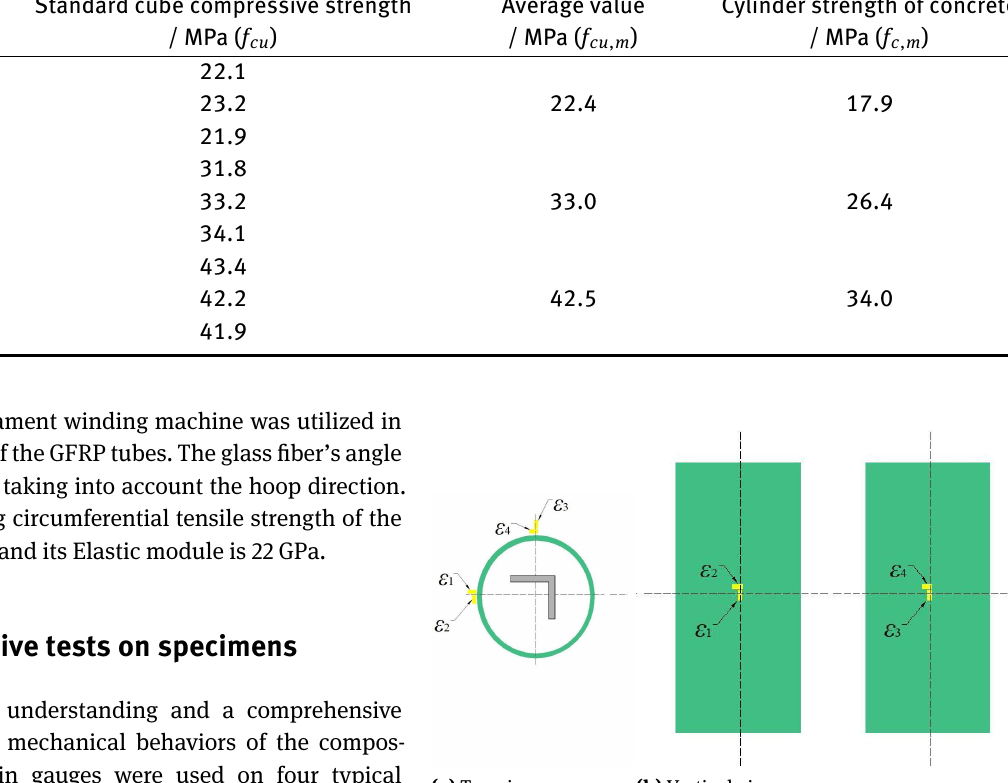
Table 4: Results of standard concrete cube tests Design strength